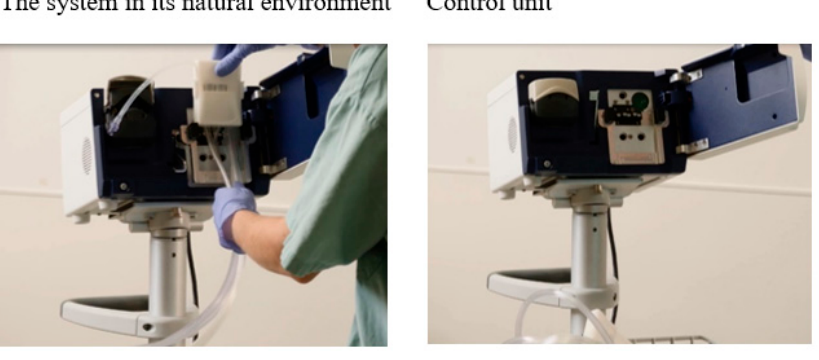
Figure 12. Single-use disposables.